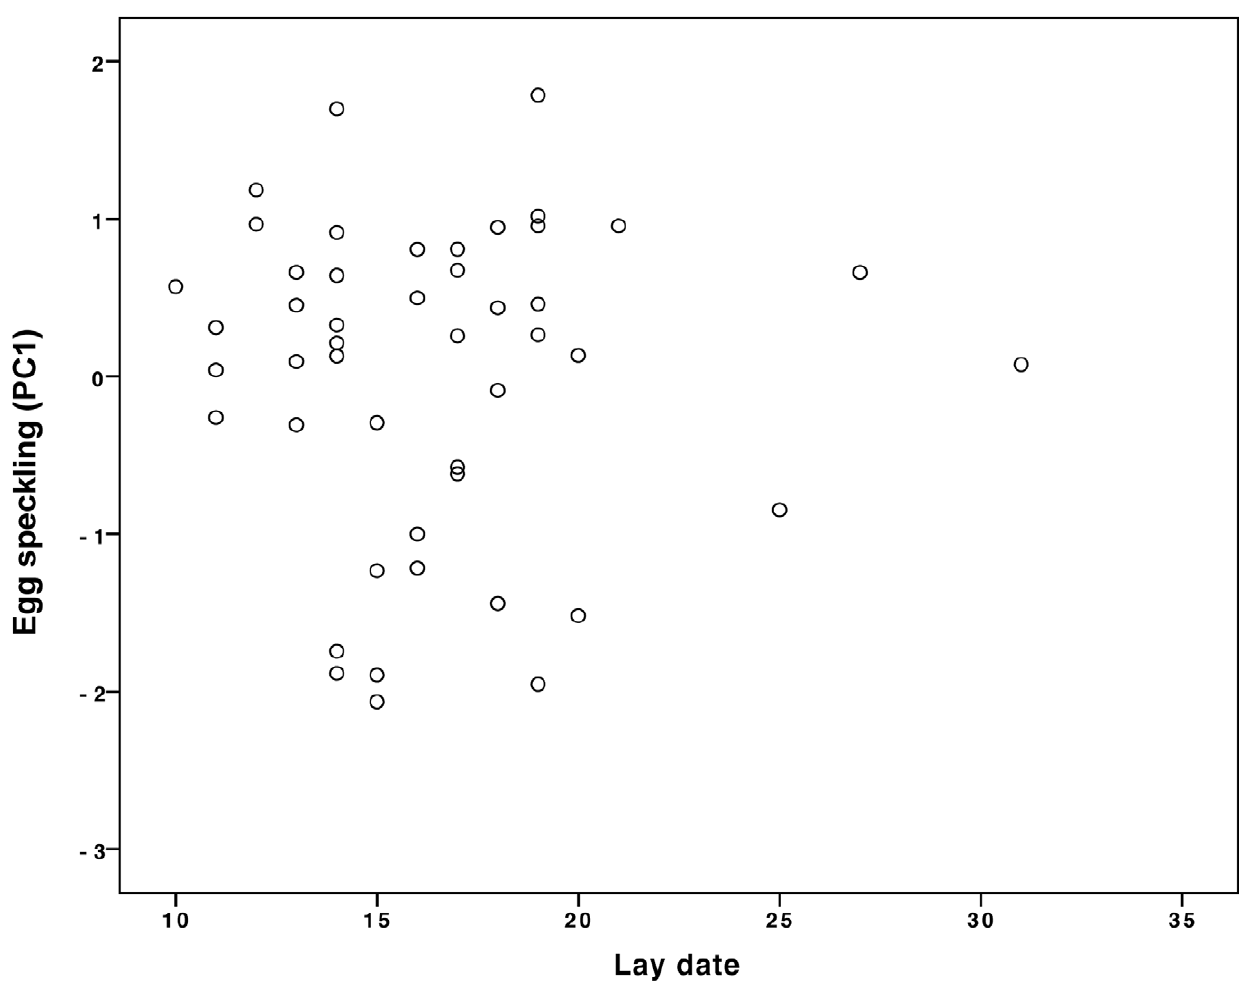
Figure 5. Female lay date had no effect on egg speckling (PC1). N=47 (see text for statistics). Lay date is the date a female laid her first egg, shown here as the number of days after 31 March 2009.